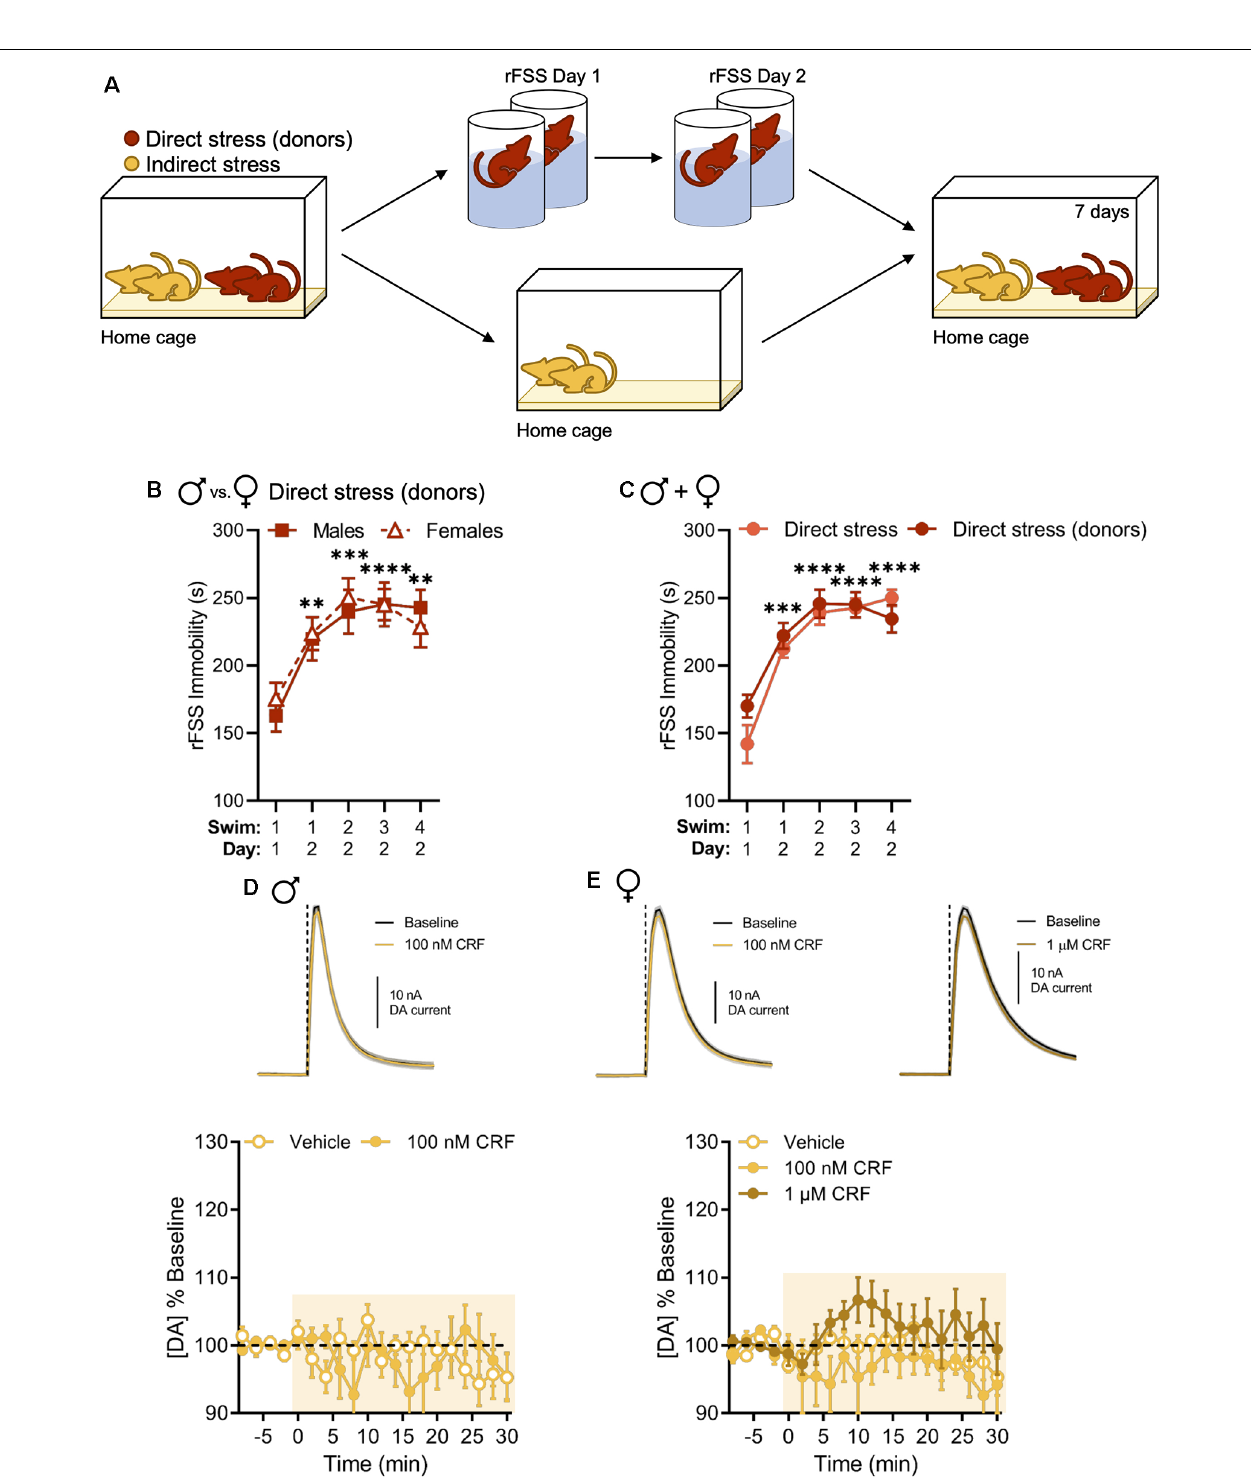
FIGURE 3 | Indirect stress disrupts CRF-mediated dopamine release in the NAc in males and females 1 week after the onset of stress exposure. (A) Mice were housed in groups of four and two mice were subjected to direct stress. The two mice that did not undergo direct stress, termed the indirect stress group, remained in the home cage for the duration of the experiment. (B,C) Cumulative time spent immobile for the first 5 min of Swim 1 on rFSS Day 1 and Swims 1–4 on rFSS Day 2 in panel (B) males ( n = 6) and females ( n = 8) that were housed with indirectly stressed animals (C) mice (male and female groups combined) belonging to the direct stress ( n = 16) and direct stress donors ( n = 14) groups. (D) Representative dopamine release evoked by electrical stimulation (dashed line) before and after